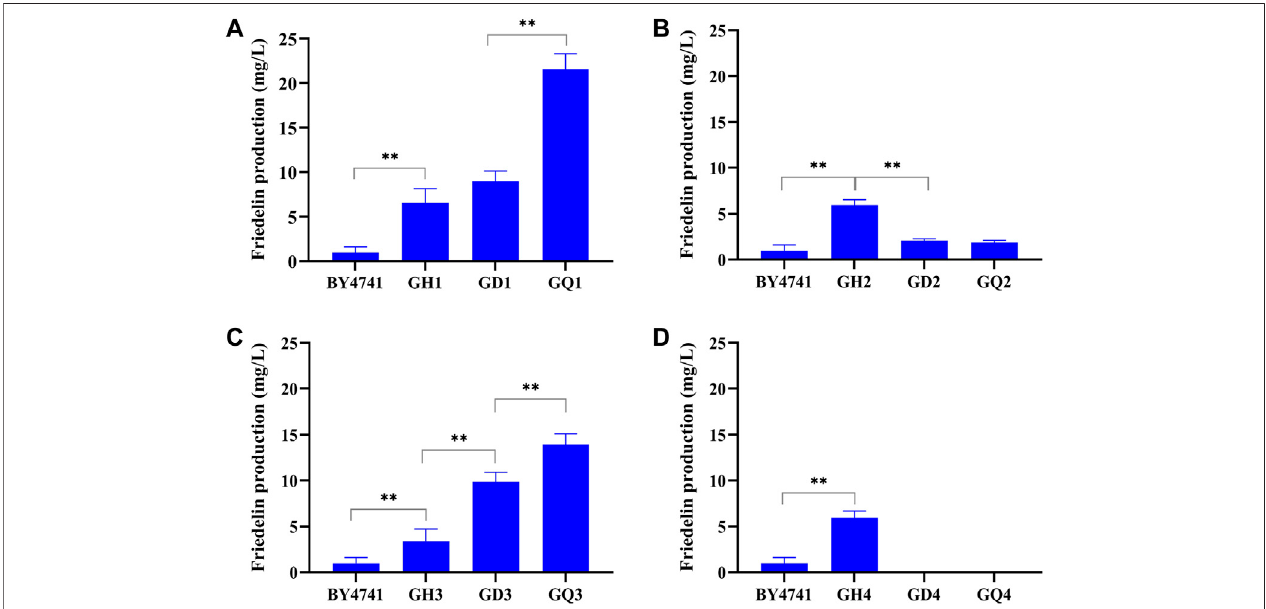
FIGURE 4 | Comparison of the yield of various recombinant strains obtained by overexpressing different gene modules and knocking out different genes. BY4741 was the original strain. GHn stands for different overexpression modules, GDn stands for knockout of two genes on the basis of overexpression, and GQn stands for knockoutof4genesonthebasisofoverexpression, n =1,2,3,4. (A) Friedelin yield ofstrains GH1,GD1,GQ1. (B) Friedelin yieldofstrainsGH2,GD2, GQ2. (C) Friedelin yield of strains GH3, GD3, GQ3. (D) Friedelin yield of strain GH4. Error bars represented standard deviations of biological